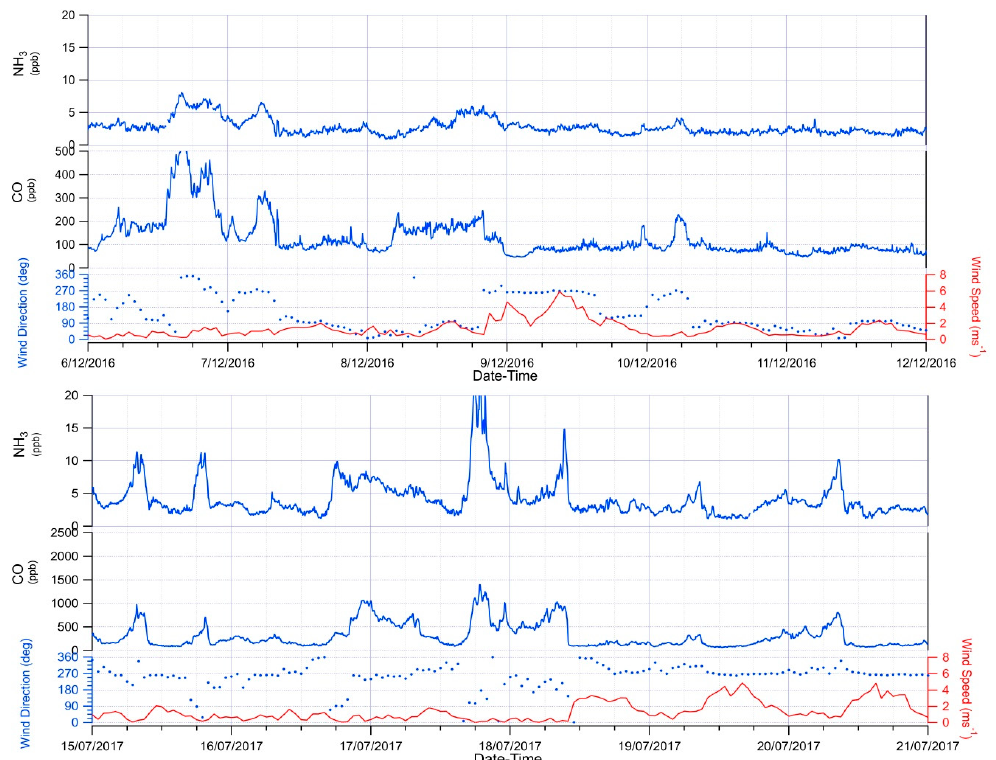
Figure 8. The time series, over 6 days, for CO and NH 3 and the corresponding wind speed (m s ‐ 1 ) and direction (°) during winter (top panel) and summer (lower panel) Illustrates the increases in